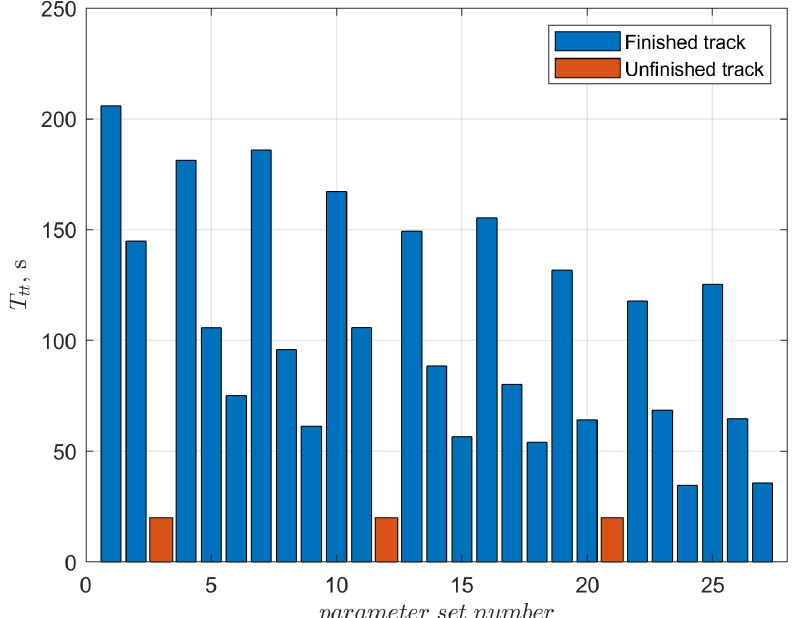
Figure 4. Time needed to path completion for the specified parameter set number—track 1.